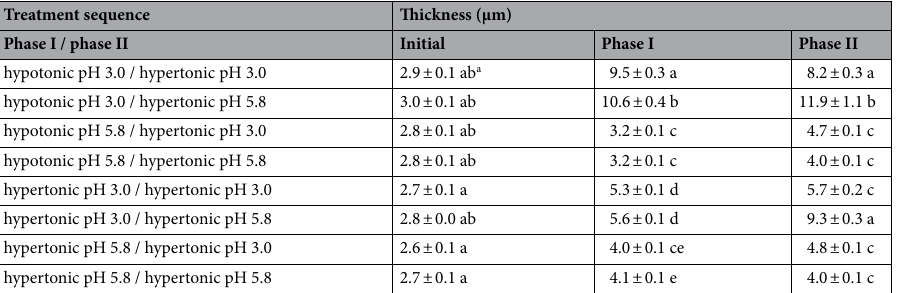
ΔThickness (µm) + turgor −turgor